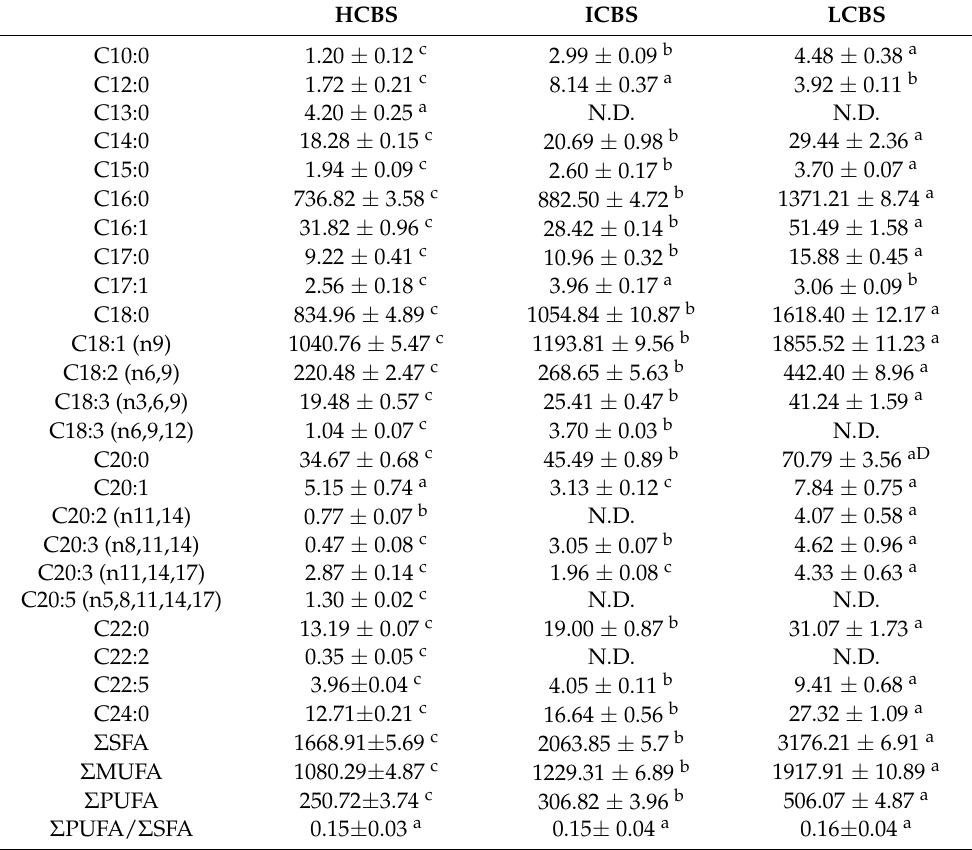
Table 4. Effect of particle size on the fatty acid profile of cocoa bean shell